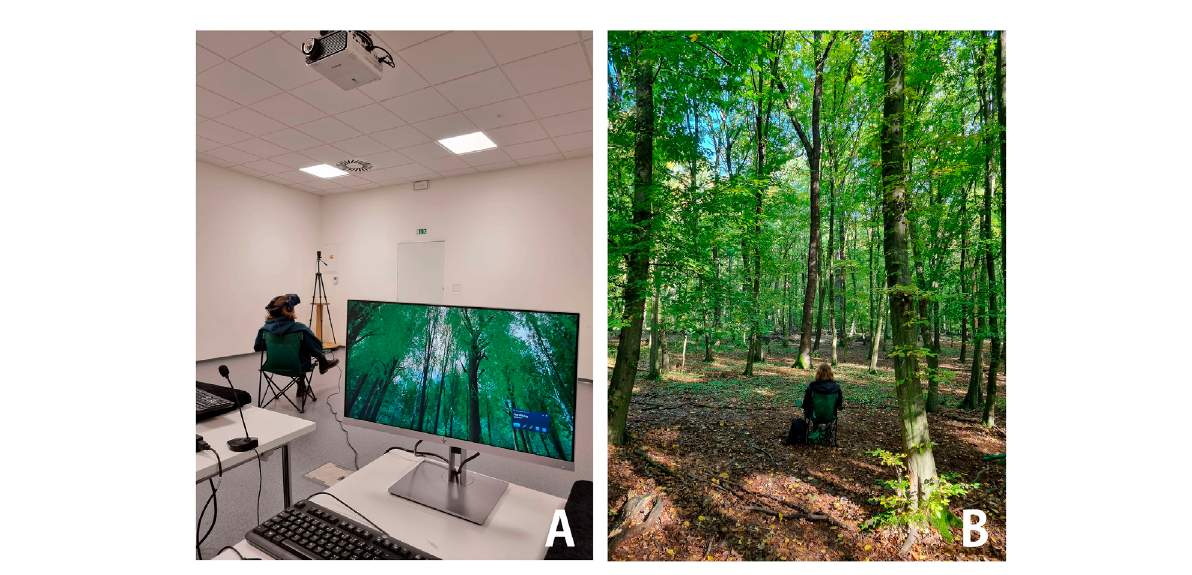
FIGURE 2 Demonstration of the virtual and the real forest bathing sessions. Sub fi gures show the sitting part of the virtual (A) and real-world (B)